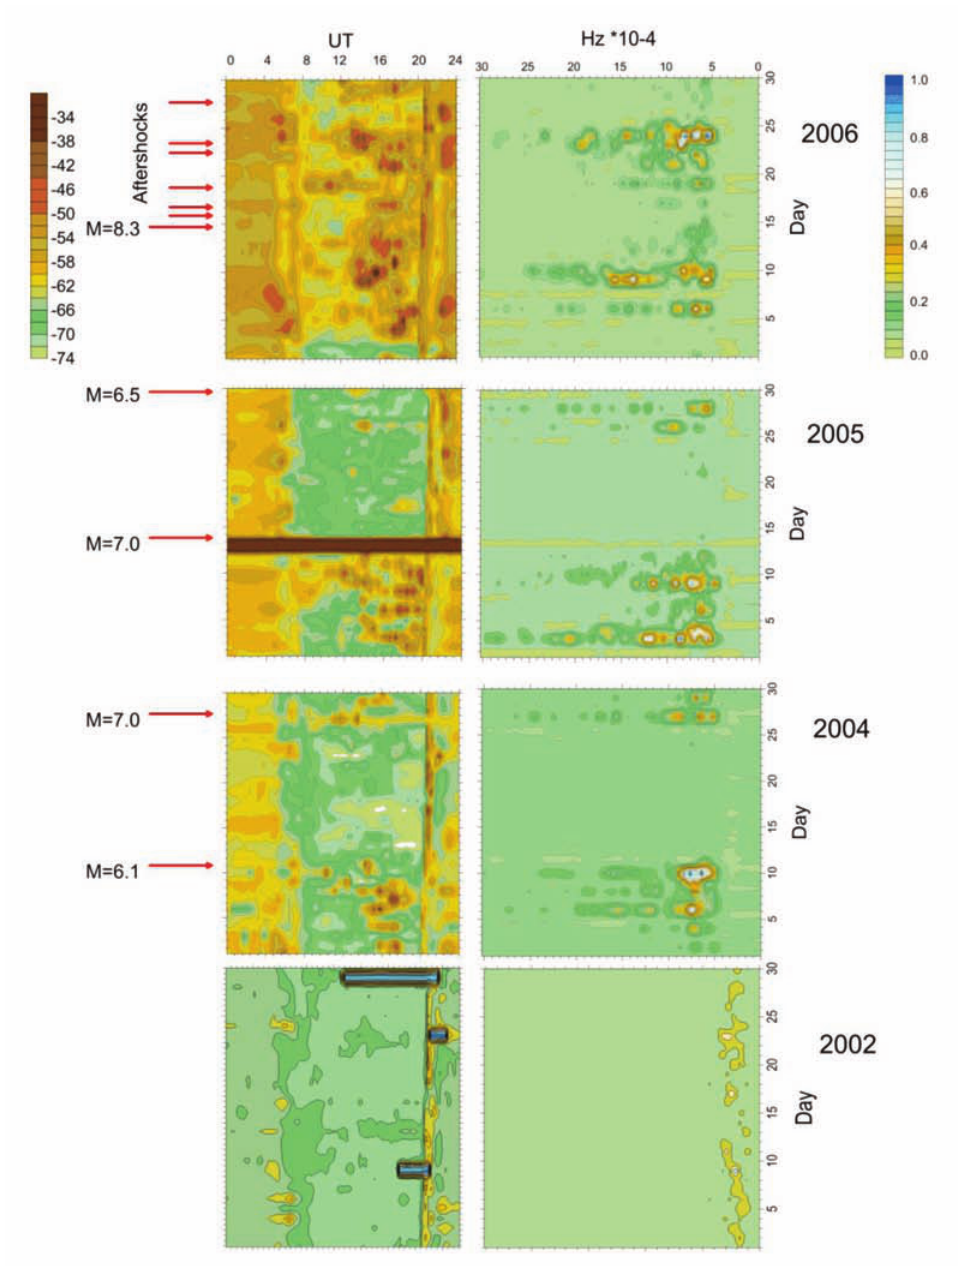
Figure 5. Time-and-frequency analysis of JJY signals received at Petropavlovsk-Kamchatsky in November 2002, 2004, 2005 and 2006. Left panels: Contour maps of the amplitudes of the JJY signal variations as a function of time of day (X-axis) and day of month (Y-axis). Right panels: Spectrograms of the filtered amplitudes of the signals as a function of frequency (X-axis) and day of month (Y-axis). Arrows indicate earthquakes with M